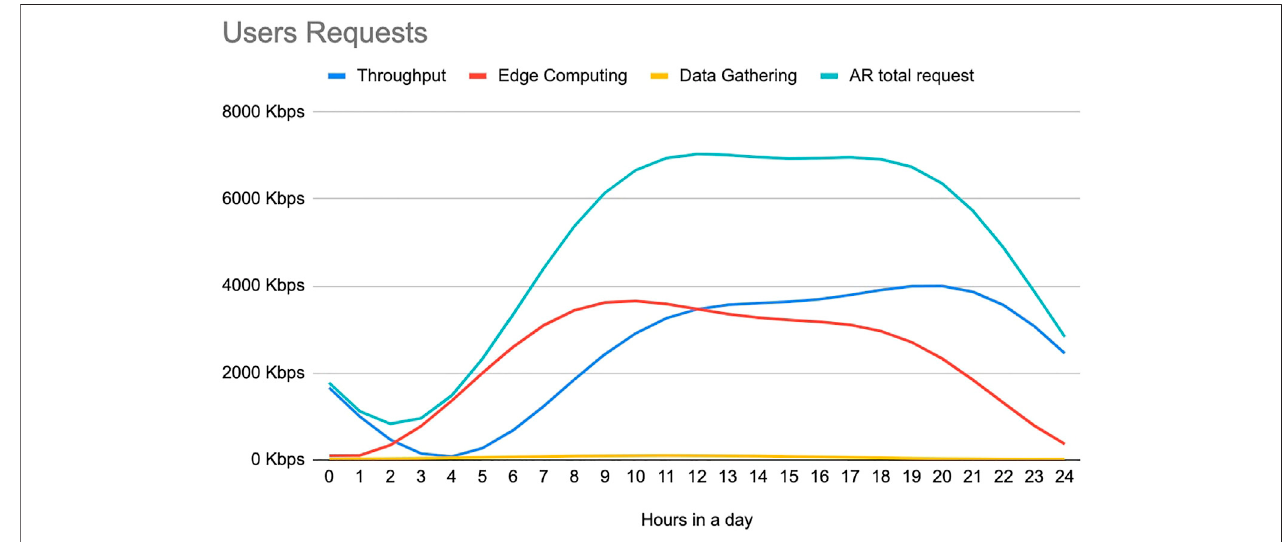
FIGURE 3 | Evolution of the three service requests and their composition during the